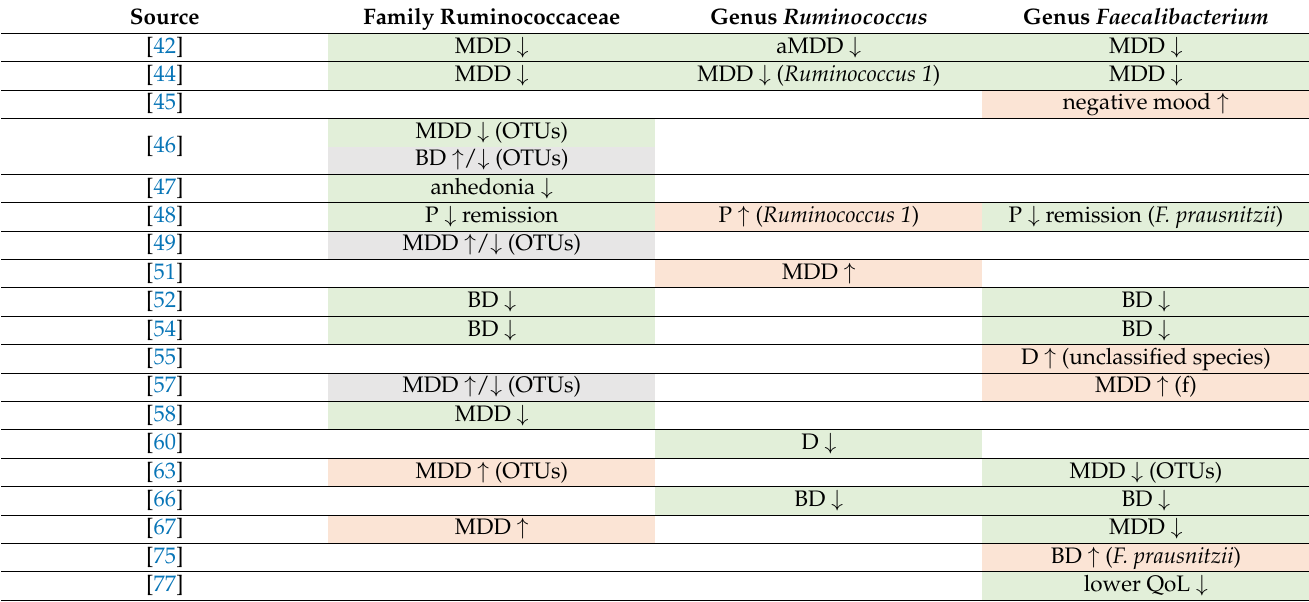
Table 5. Different abundance of family Ruminococcaceae and two of its members, genus Ruminococ- cus and